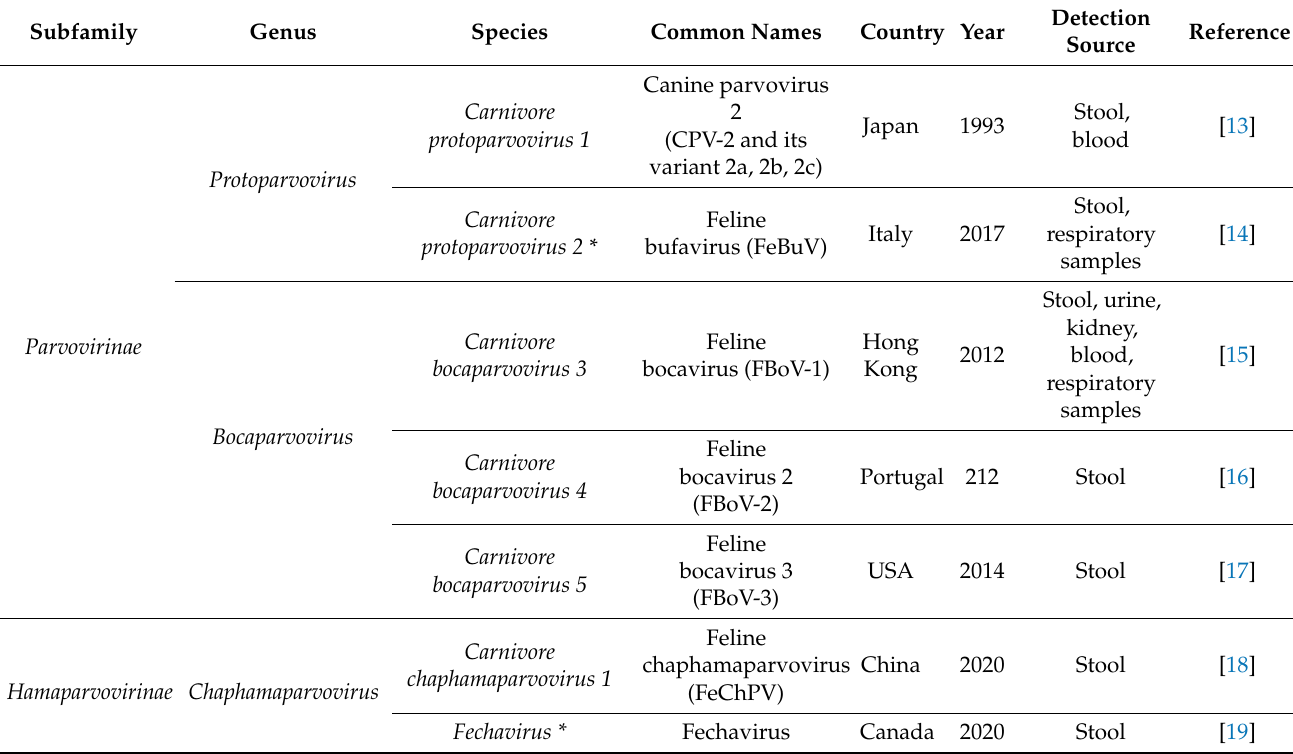
Table 1. Emerging parvoviruses detected in cats and their current